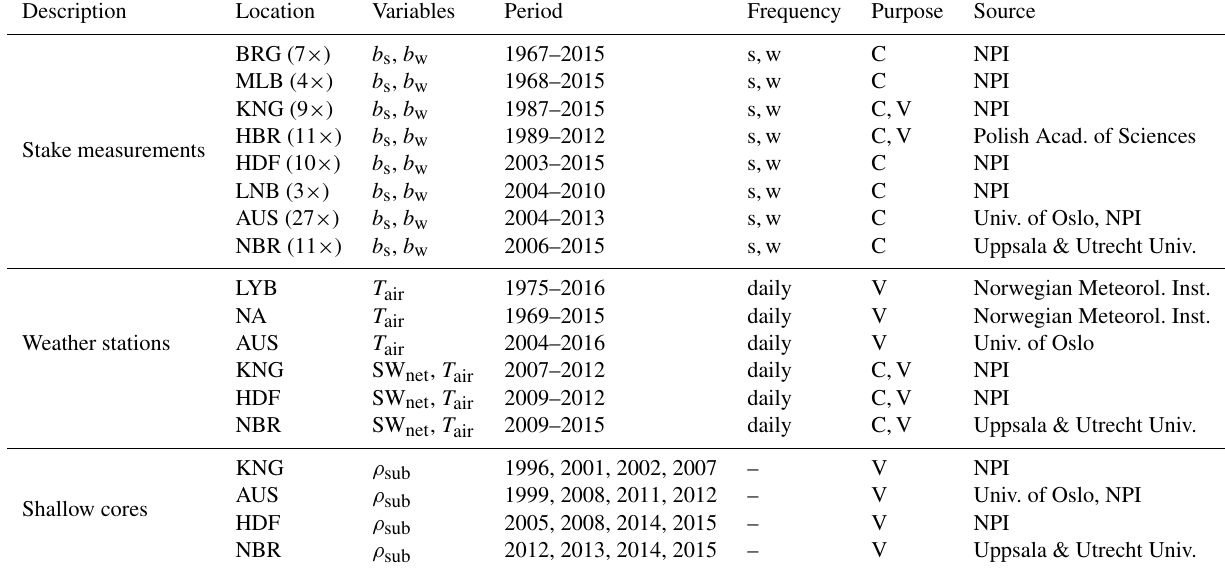
Table 1. Overview of in situ observational data used in this study. The number of stake locations per glacier are indicated in brackets in the second column. Location abbreviations are shown and described in Fig. 1. Variable names are introduced in the text. Other abbreviations: s: summer, w: winter, C: calibration, V: validation, NPI: Norwegian Polar